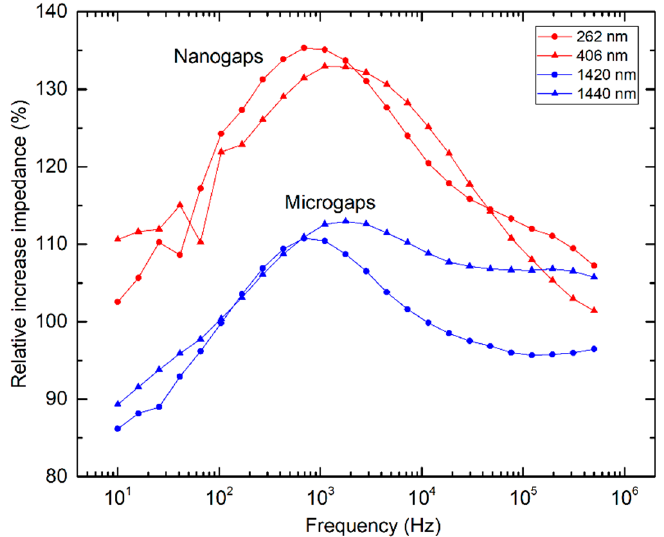
Figure 3. Relative increase of impedance after ssDNA immobilization using IDA sensors with nanogaps (262 and 406 nm) and micrometer sized electrode gaps (1.42 and 1.44 μ m).